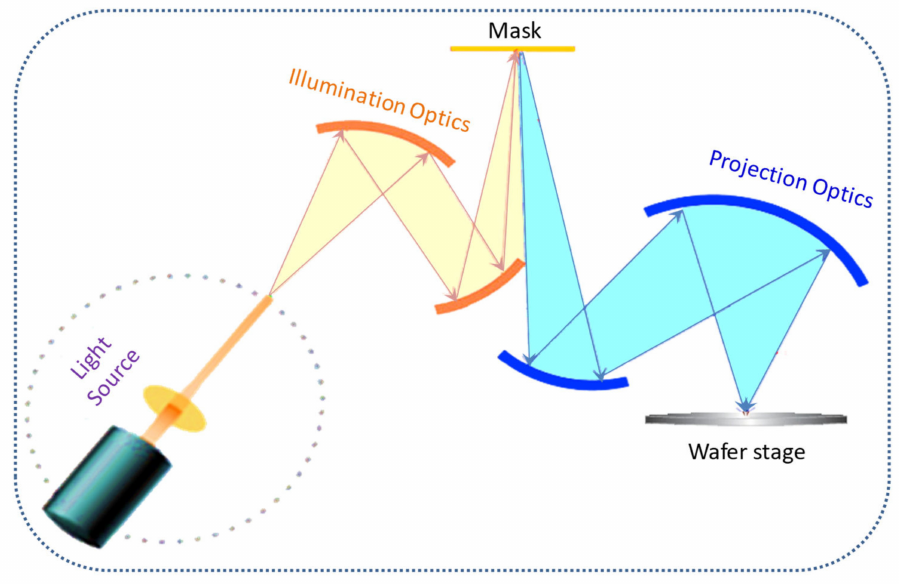
Figure 6. Set up for EUVL technique.